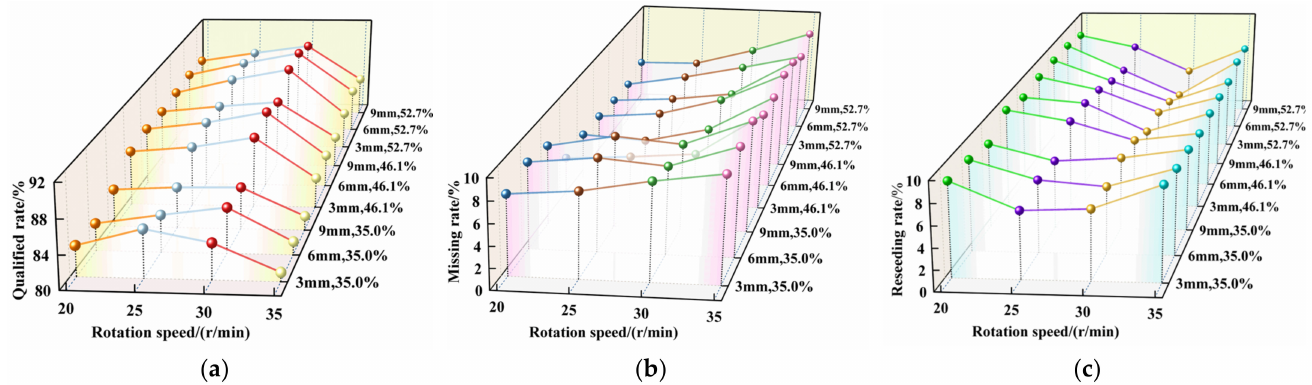
Figure 8. The effect of experimental factors on seed metering performance. ( a ) Qualified rate; ( b ) missing rate; ( c ) reseeding